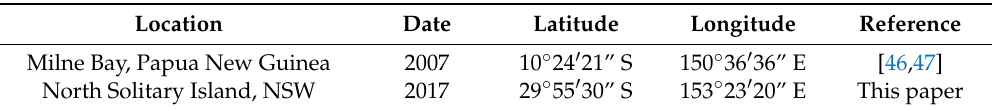
Table 4. Global distribution records of Elysia